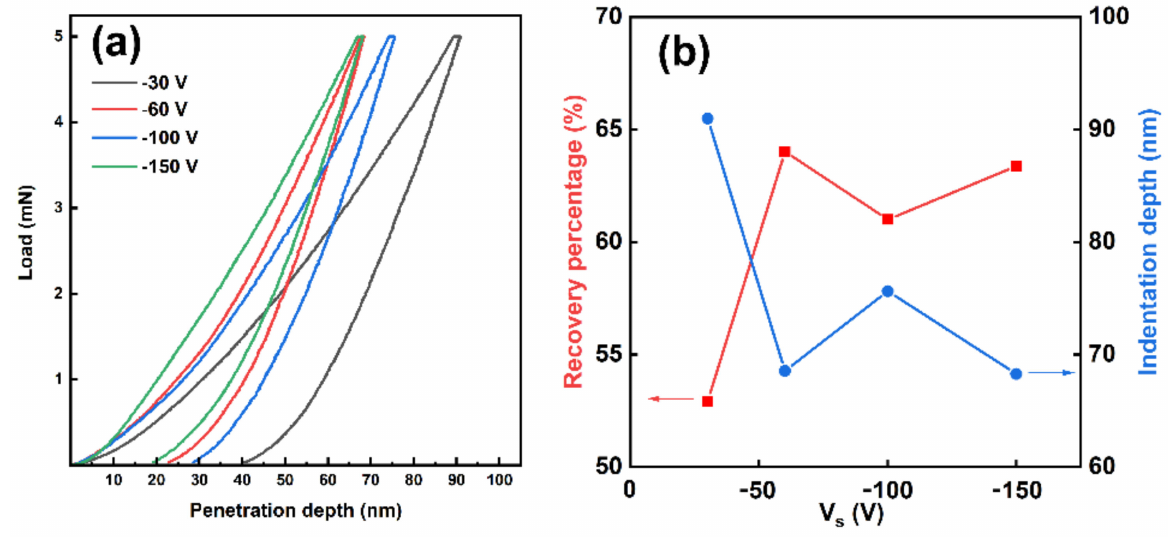
Figure 9. ( a ) Load–displacement curves with various V s and ( b ) corresponding to recovery percentage and indentation depth.